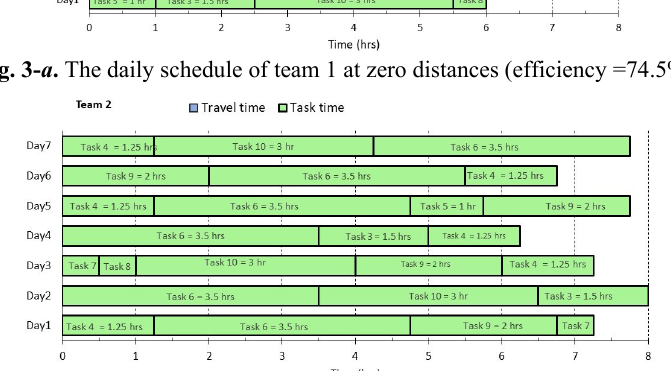
Fig. 3- b . The schedule of team 2 at zero distances,